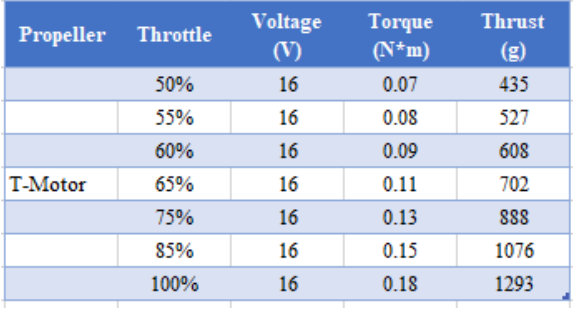
Fig. 9. Test report AIR2216 880KV